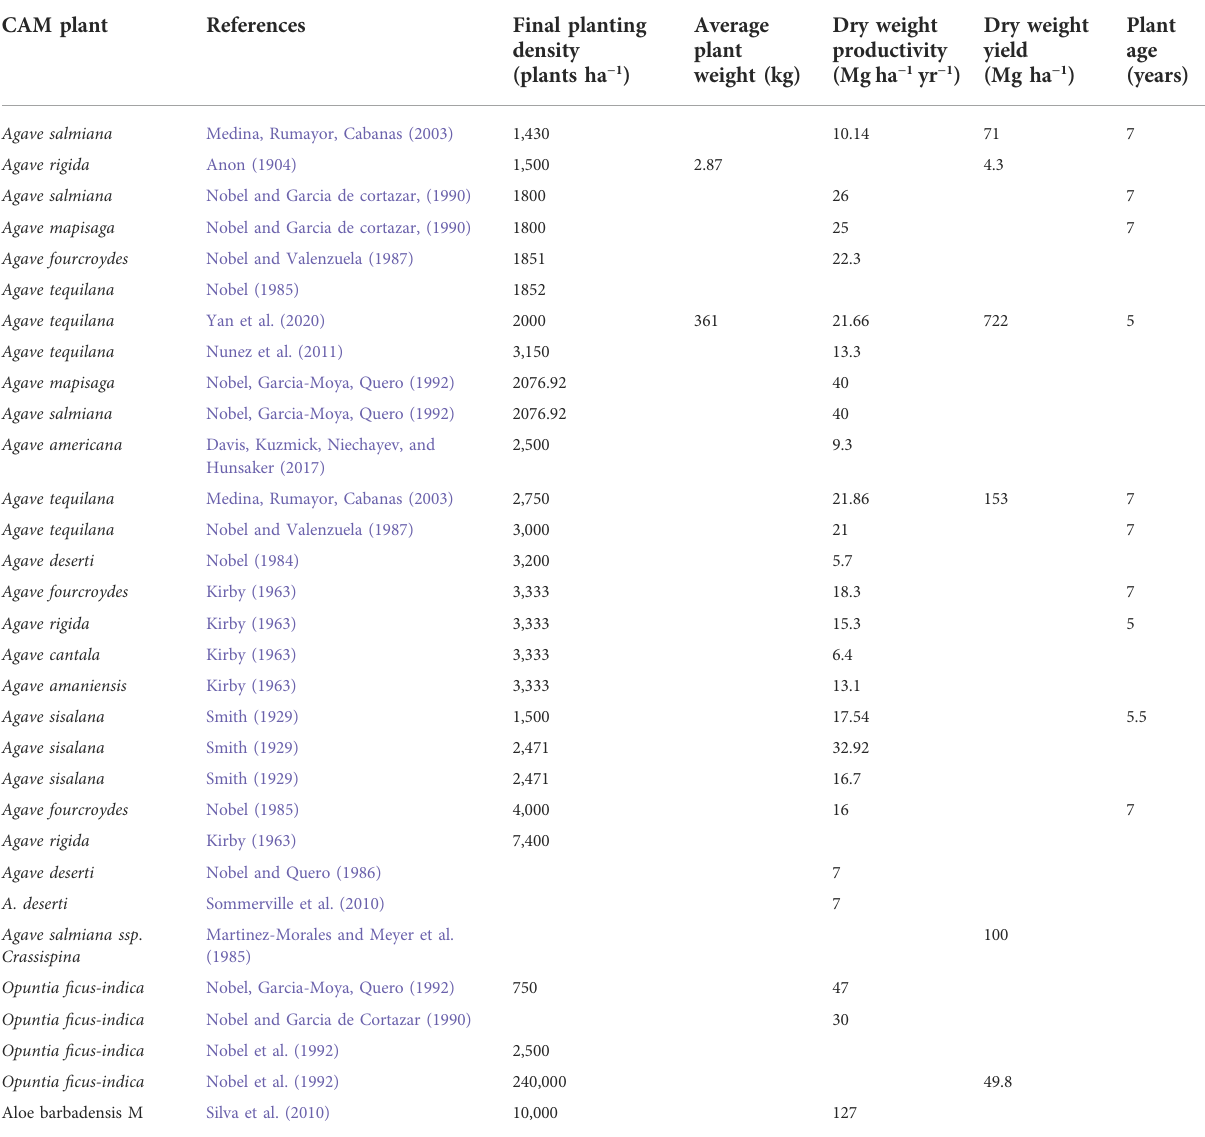
TABLE 1 CAM productivity and density data collated. CAM